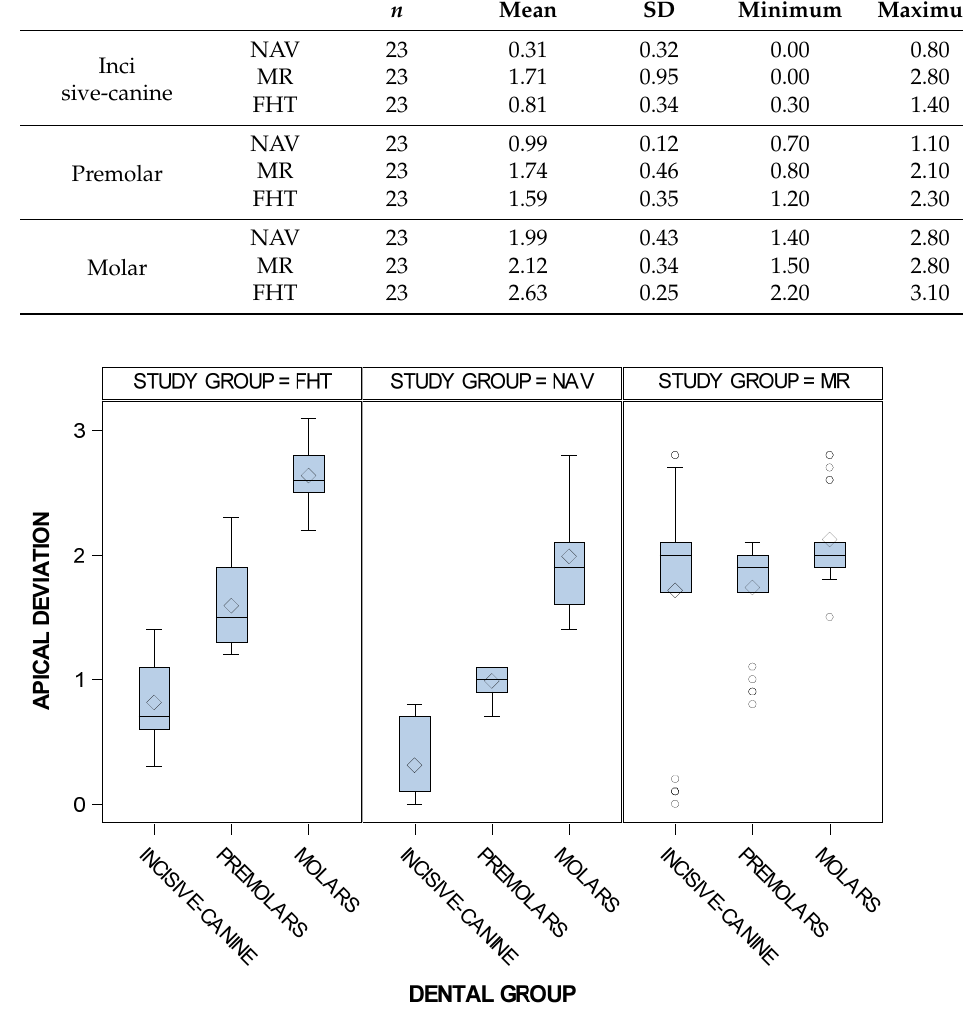
Figure 9. Box plot of the apical end-point deviations of the orthodontic micro-screws placed using the computer-aided static navigation technique, mixed reality technique and conventional freehand technique in the incisive-canine, premolar and molar dental sectors.